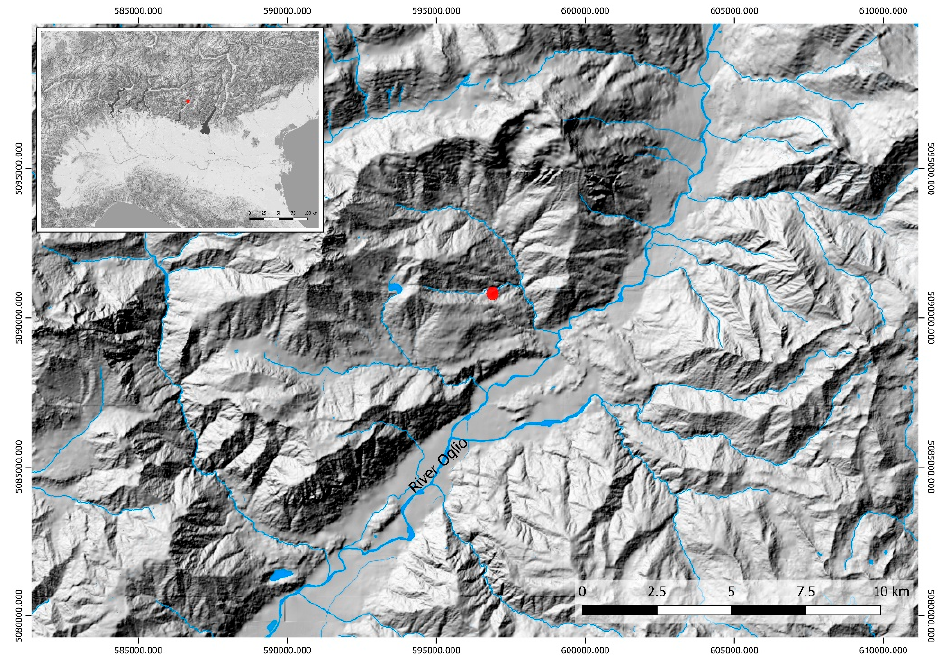
Figure 1. Location of the Ossimo-Pat site in Middle Valle Camonica (GIS elaboration on LIDAR DTM base).